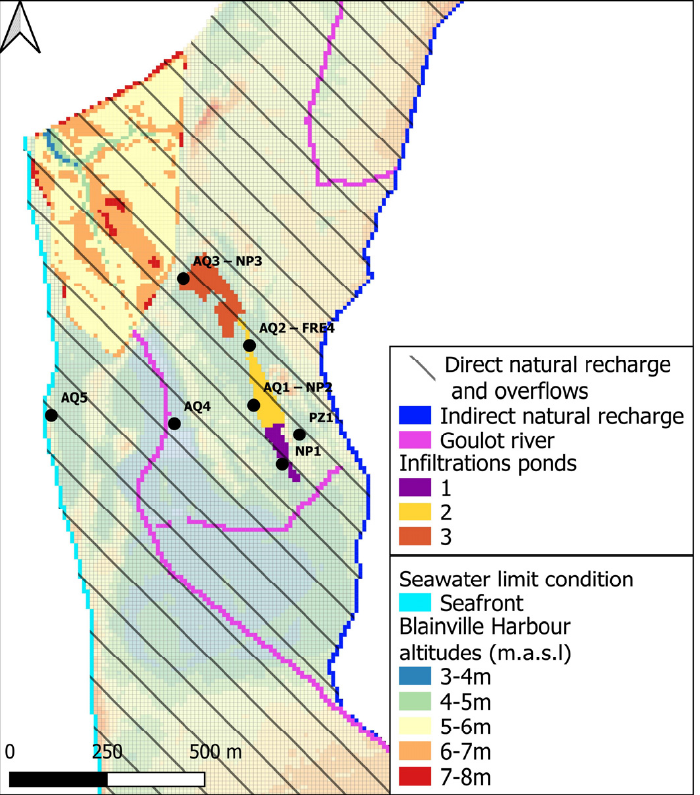
Figure 5. Boundary conditions applied to the numerical mesh hydrodynamic model M ARTHE .